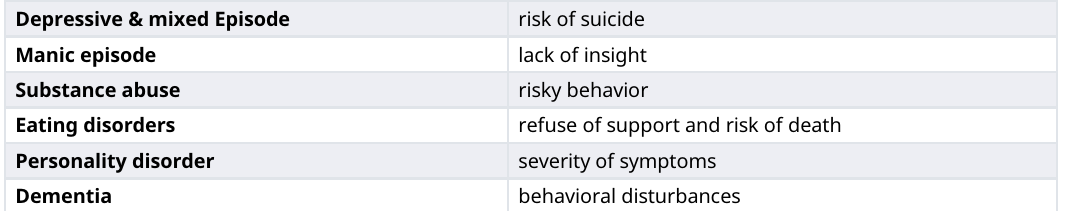
Table 4. Most frequent reason for compulsive treatment (CT) in clinical practice (Pignon et al. 2014). Depressive & mixed